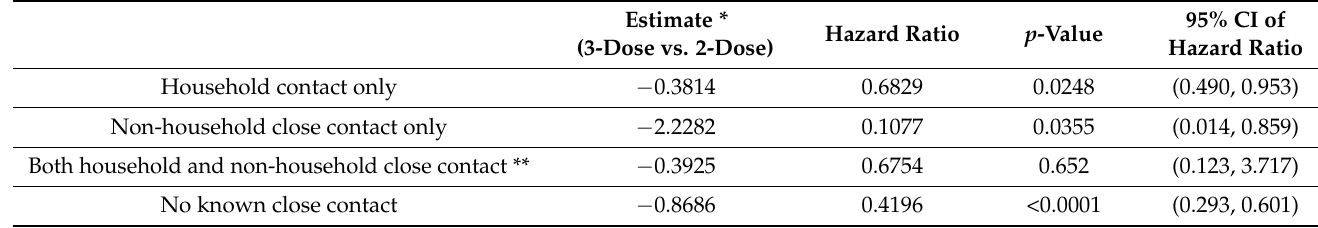
Figure 1. Hazard ratio for COVID-19 and associated 95% confidence interval. Table 5. Time-dependent Cox regression analysis on effect of 3-dose vs. 2-dose regime on risk of acquiring COVID-19 in household and non-household close contact